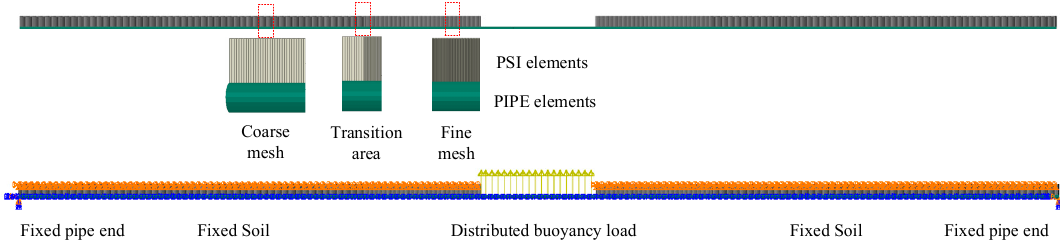
Figure 5. Sketch of the finite element model for buried pipeline subjected to buoyancy load.